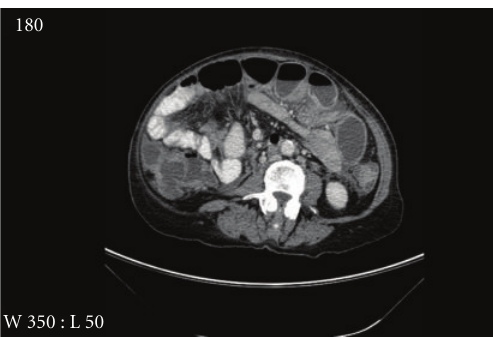
Figure 1: CT scan shows small bowel dilatation, no other specific features.